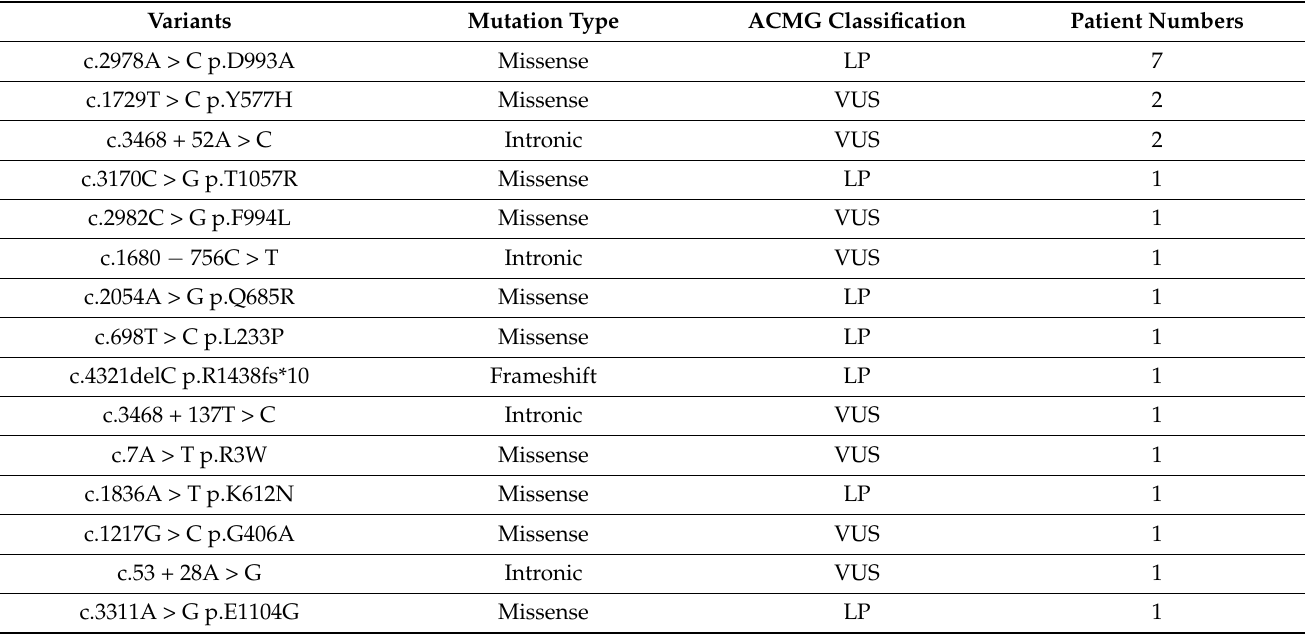
Table 1. Detected novel variants and American College of Medical Genetics (ACMG) criteria provided with pathogenicity classification.